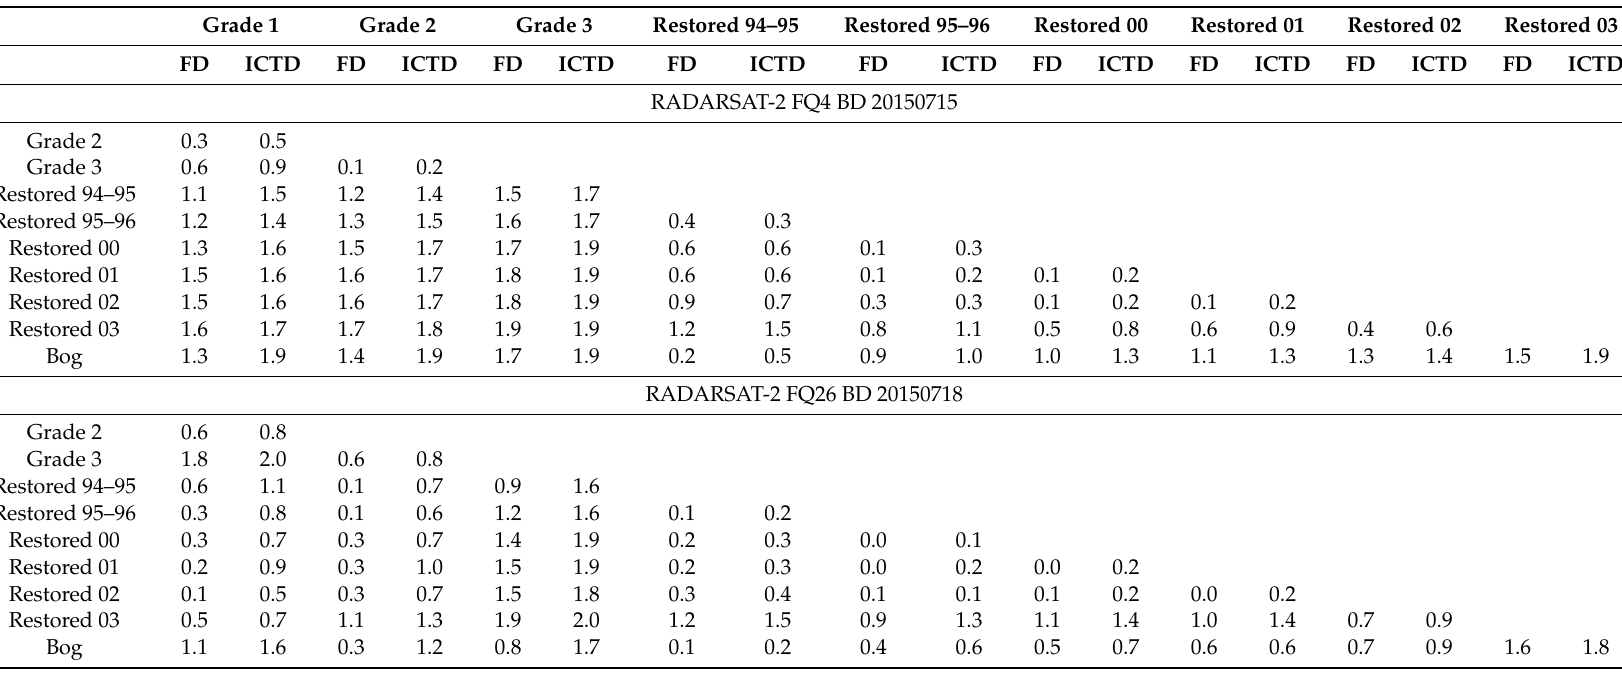
Table 2. Bhattacharya distance (BD) statistic for the FQ4 15 July 2015, and FQ26 18 July 2015, RADARSAT-2 images. The BD value indicates whether the spectral responses of natural shrub bog, restored peat, and actively harvested peat can be separated. Values range from 0 to 2.0. All values equal to or greater than 1.9 indicate good spectral